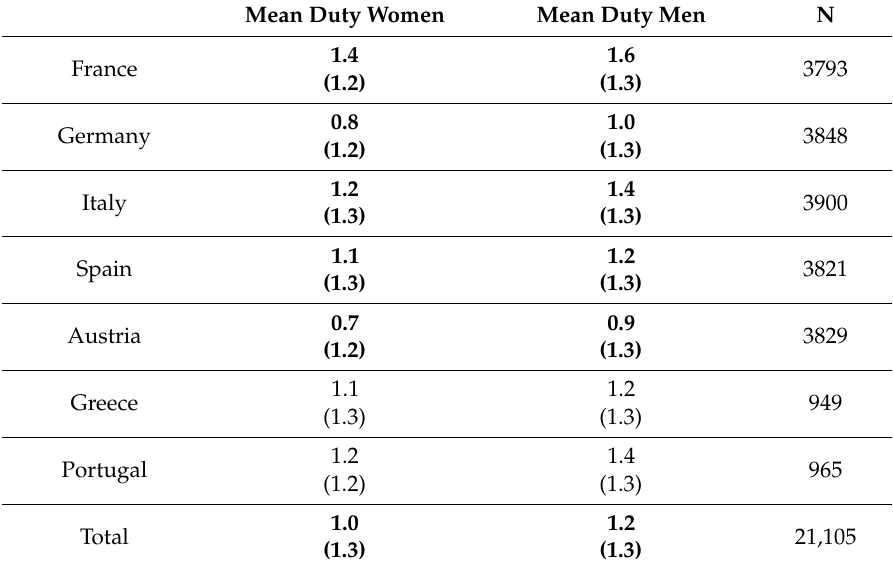
Table 3. CEESP 2014. Duty averages by gender and country.